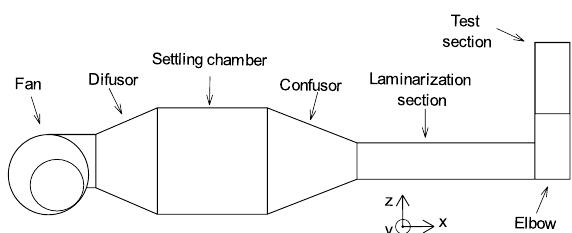
Fig. 1. Schematic layout of the wind tunnel with a vertical test section.